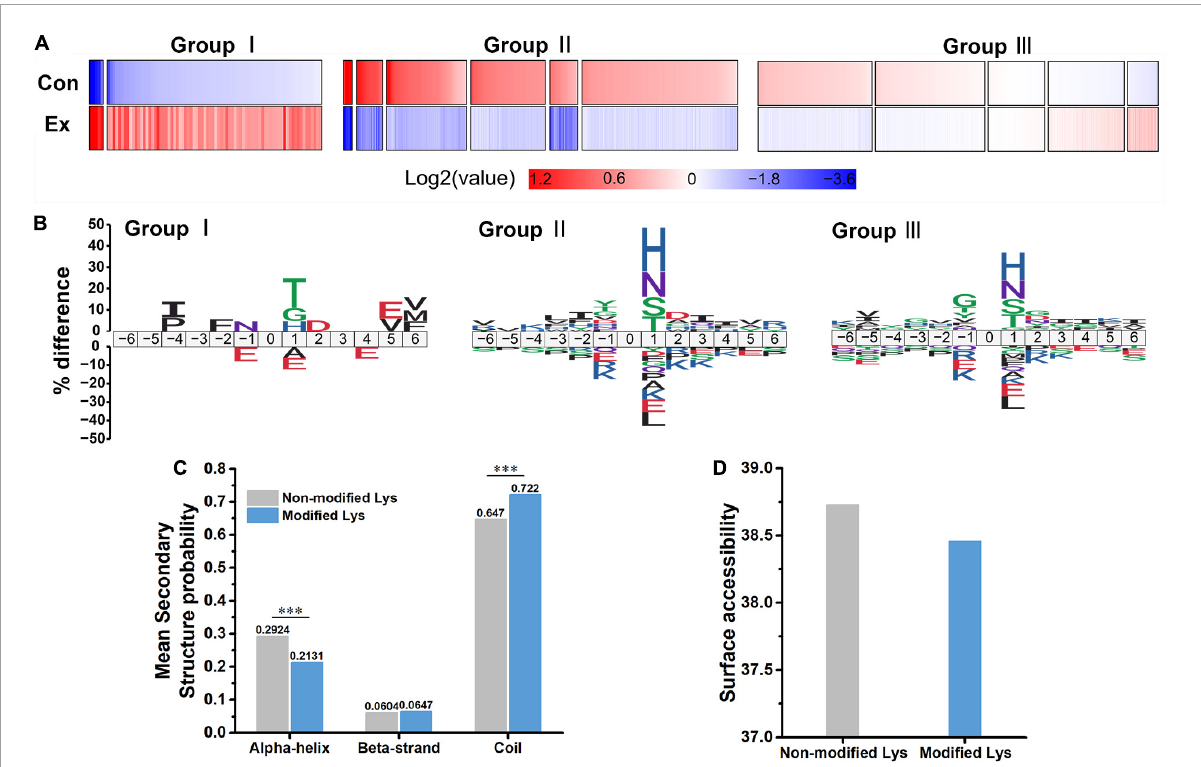
FIGURE3 Characteristics of acetyl isoforms in response to chronic exercise. (A) Three groups based on the trends of the quantified acetyl sites upon chronic exercise. Group I sites were upregulated by chronic exercise; Group II sites were downregulated in response to exercise; and Group III exhibited unchangeable. (B) Predicted amino acid motifs for each group. The motif showed significant ( p < 0.05, binomial test) amino acid at each site flanking the position 0 lysine. (C,D) The conformational tendencies of 272 differentially acetylated sites predicted by protein secondary structures and surface accessibility. Compared with the non-modified lysine residues, the differentially acetylated sites were significantly enriched in coil ( p = 9.80 × 10 − 13 ) and depleted in alpha-helical regions ( p = 1.26 × 10 − 11 , Wilcoxon rank sum test), while showed no difference in surface-exposed accessibility (Wilcoxon rank sum test). ∗∗∗ p <